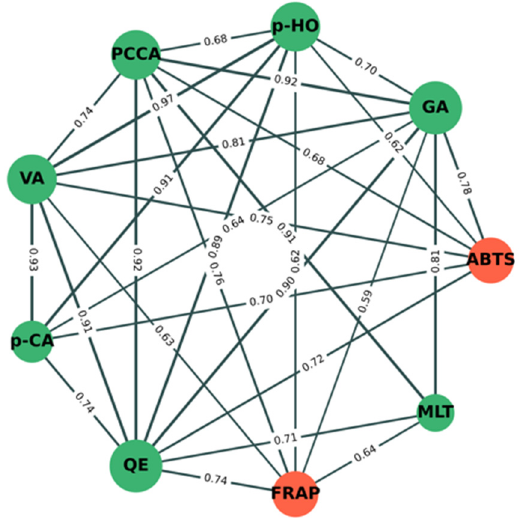
Figure 5. Correlation network analysis of phytochemical components and antioxidant activity be- tween mung bean seeds and mung bean sprouts under different conditions. Green and orange nodes indicate phytochemical components and antioxidant activity, respectively. Correlation coefficient values ( r ) between nodes are shown on green lines. Edge (line) thickness indicates strength of correlation between node pairs.